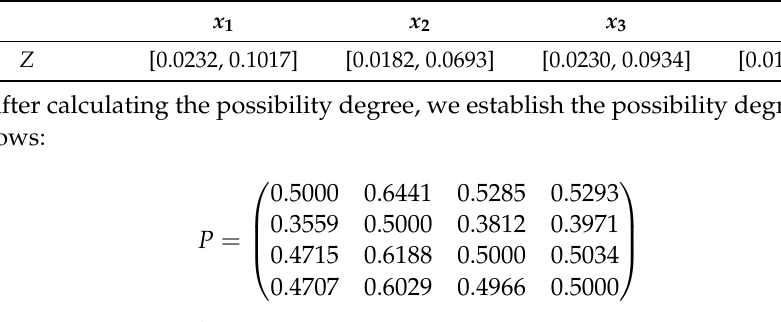
Table 6. Interval value vector of the comprehensive attribute.